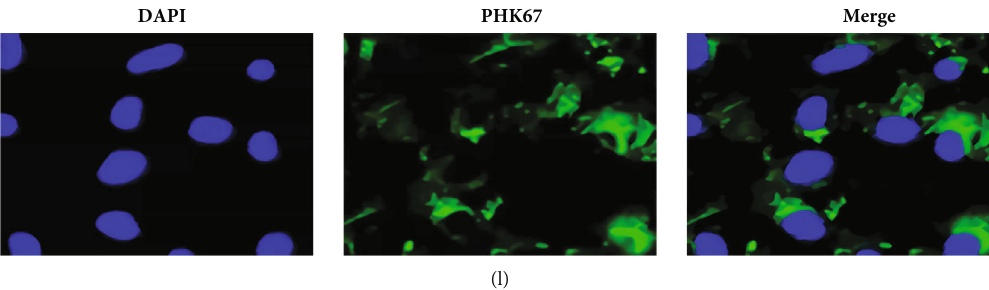
Figure 1: Morphology and characterization of BMSCs, NPCs, and BMSC-Exos: (a) P0-generation BMSC morphology (scale bar: 200 μ m); (b) Oil Red O staining (scale bar: 100 μ m); (c) Alizarin Red staining (scale bar: 100 μ m); (d) Alcian Blue staining (scale bar: 50 μ m), n = 3 ; (e) fl ow cytometric analysis of BMSC surface markers (CD29, CD90, CD34, and CD45); (f) NPC morphology (scale bar: 200 μ m); (g) toluidine blue staining of NPCs (scale bar: 100 μ m); (h) type II collagen immunochemical staining of NPCs (scale bar: 100 μ m); (i) transmission electron microscopy (TEM) image of BMSC-Exo (scale bar: 200nm); (j) NanoSight tracking analysis (NTA) for the diameters of BMSC-Exo; (k) Western blot analysis of CD9, CD63, and TSG101, n = 3 ; (l) analysis of cellular exosome uptake by NPCs. n = 3 . Scale bar: 25 μ